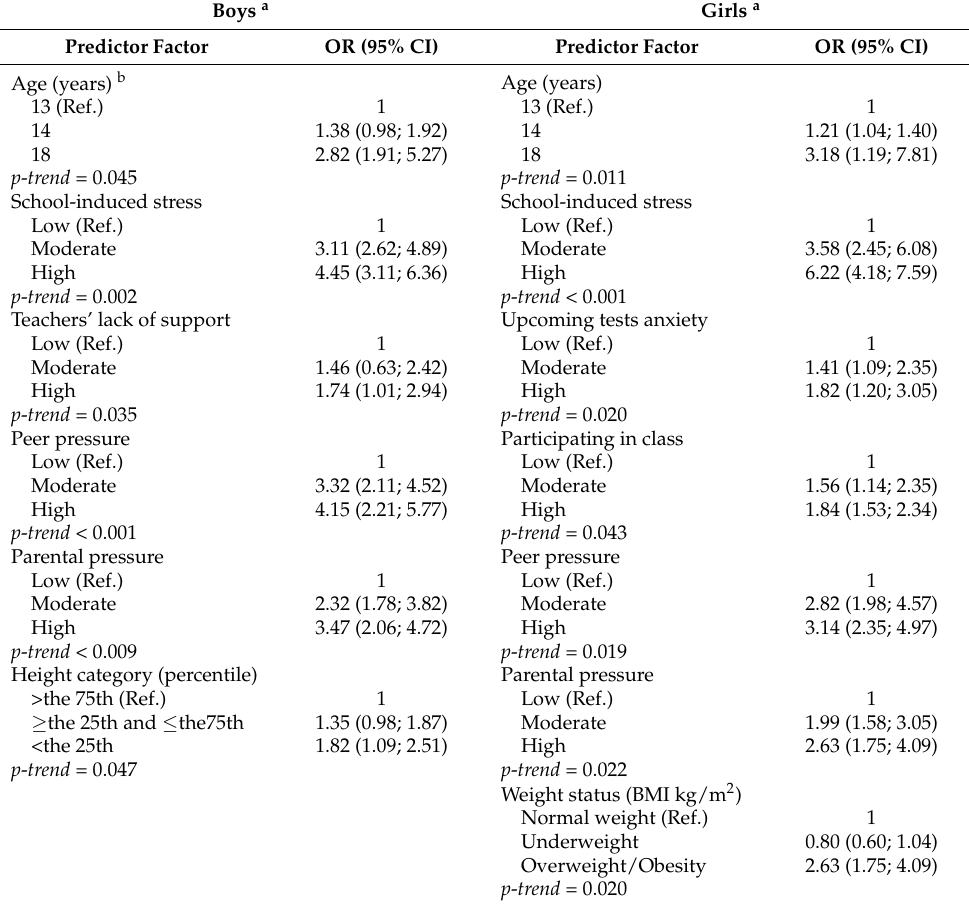
Table 5. The best subset of predictor factors affecting the likelihood of experiencing high level of perceived stress in adolescent boys and girls: results of multivariate logistic regression analysis, adjusted odds ratio, and 95% confidence